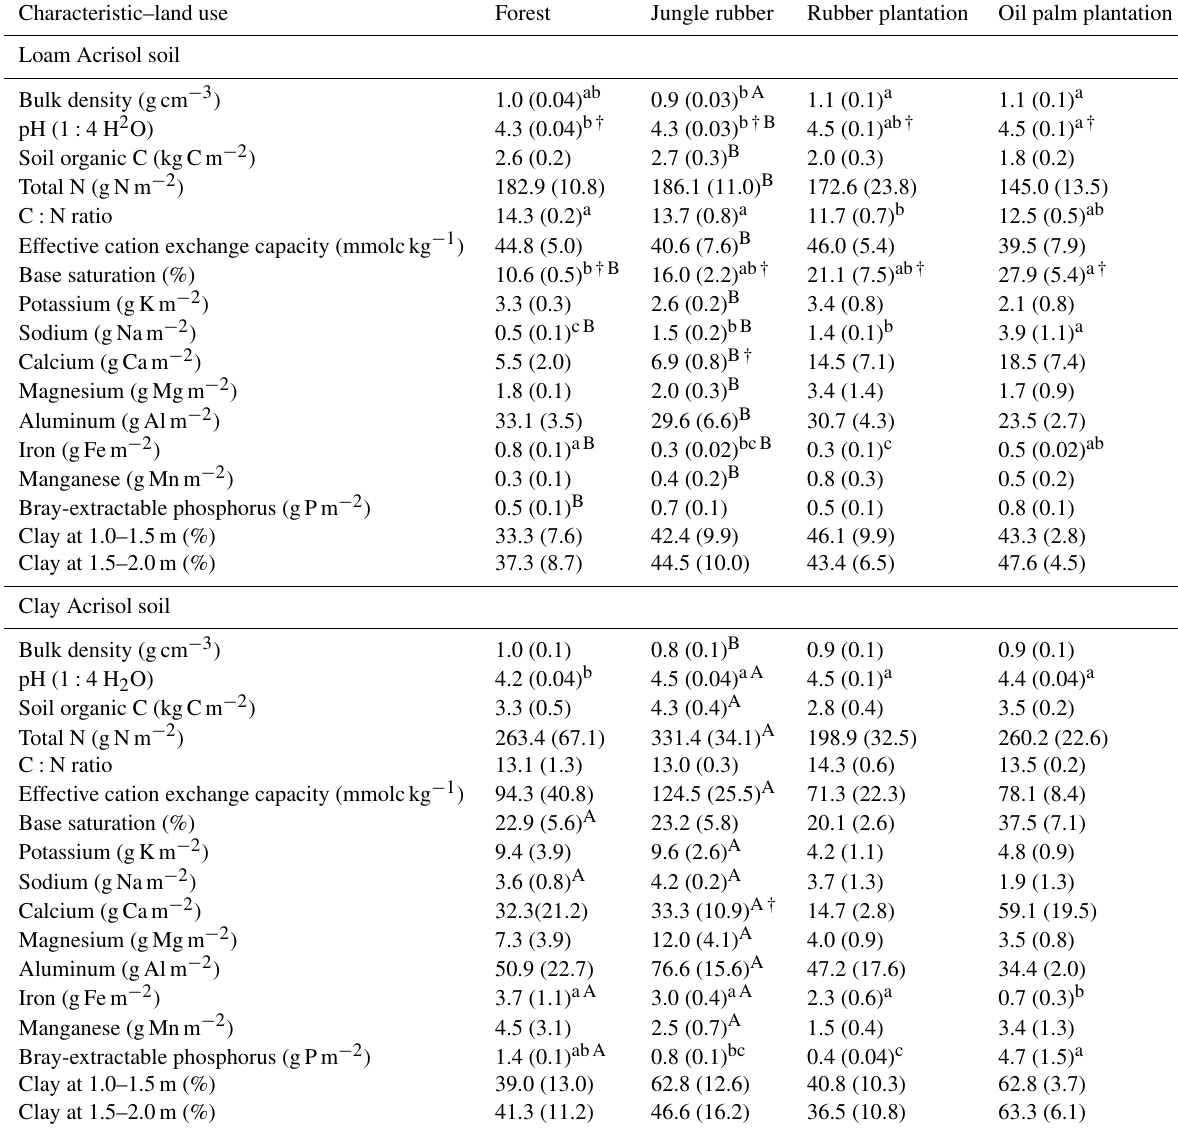
Table A1. Soil characteristics in the top 0.1m of soil (except for clay content, which is for 1–2m) in different land uses within the loam and clay Acrisol soils in Jambi, Sumatra, Indonesia. Means ( ± SE, n = 4, except for clay content n = 3) followed by different lowercase letters indicate significant differences among land uses within each soil type and different uppercase letters indicate significant differences between soil types for each reference land use (linear mixed-effects models with Fisher’s LSD test at P ≤ 0 . 05 and † at P ≤ 0 . 09 for marginal significance). These soil characteristics were reported by Allen et al.